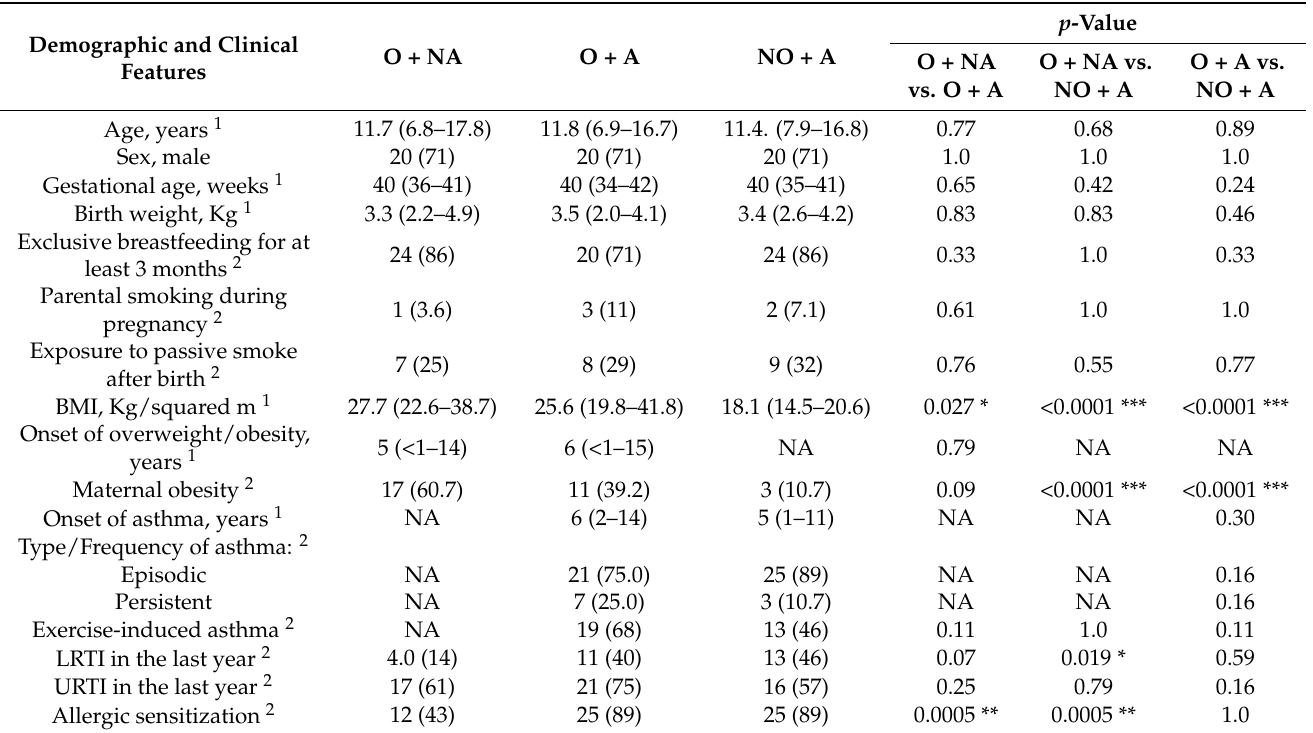
Table 1. Patient’s demographic and clinical features. Twenty-eight children with obesity and asthma (O + A) were compared with 28 children with obesity and no asthma (O + NA) and with 28 children with asthma and no obesity (NO + A) overlapped for age ( ± 1 year) and gender (males 71.4%). Values are expressed as median and minimum-maximum ( 1 ) or absolute value and percentage ( 2